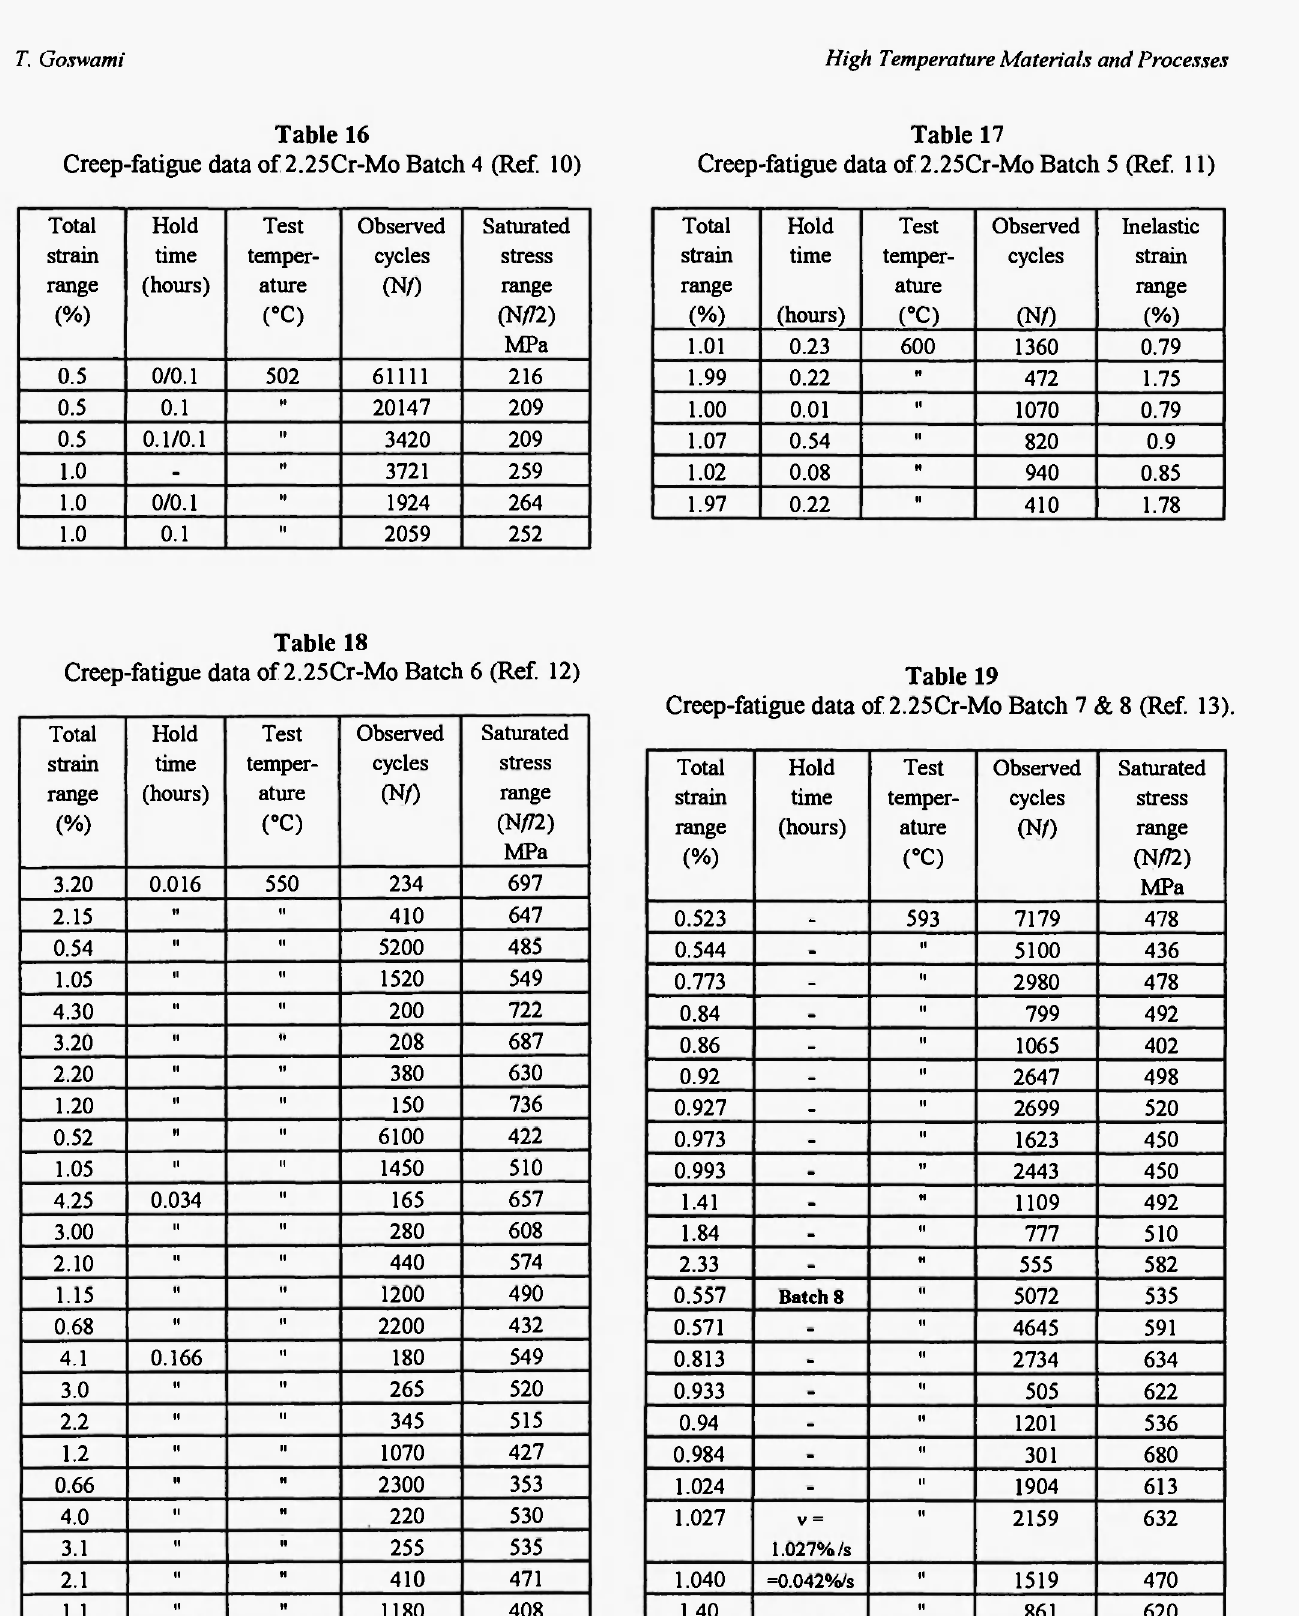
Creep-fatigue data of 2.25Cr-Mo Batch 4 (Ref. 10)